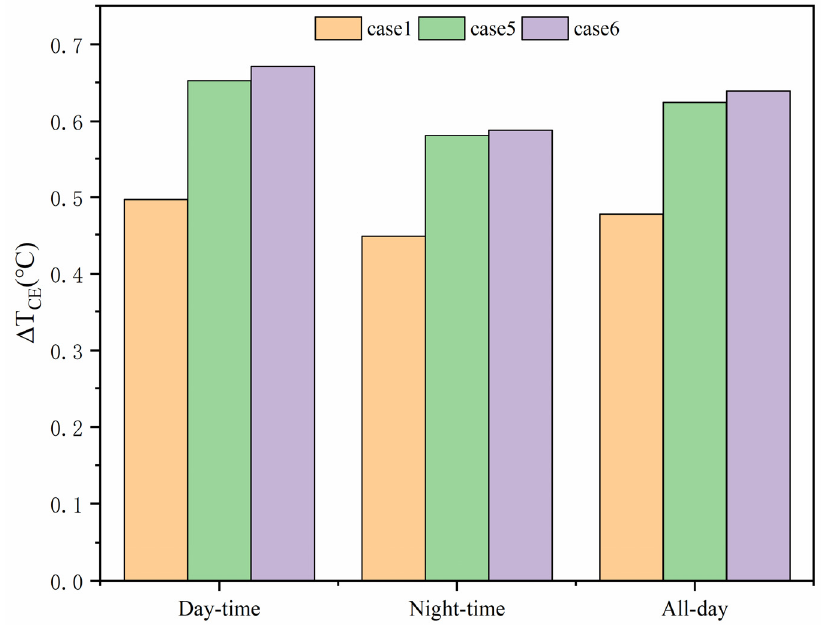
Figure 9. Daytime, nighttime, and all-day cooling effects in cases 1, 5 and 6.